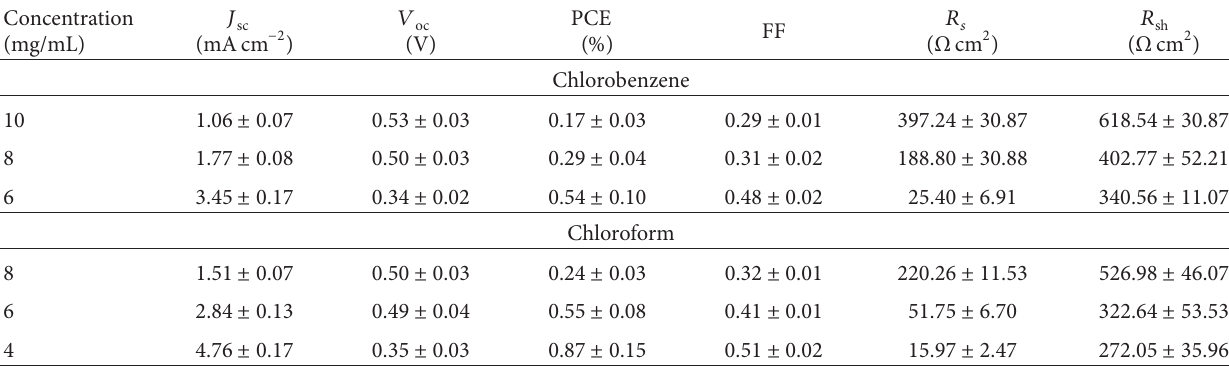
F 5: AFM images of blend �lms of Eosin-�-coated ZnO NRAs and organic photoactive layer prepared from CB at concentrations (a) 10mg/mL, (b) 6mg/mL and prepared from CF at concentrations (c) 8mg/mL, (d) 4mg/mL. T 1: Summary of photovoltaic parameters of devices at various solution